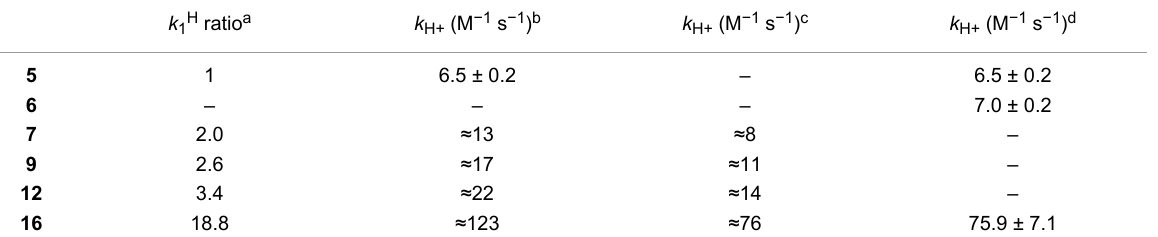
Table 3: Calibrating ratios of k 1H for 5 , 7 , 9 , 12 and 16 with respect to experimentally determined values of 5 and 16 from this